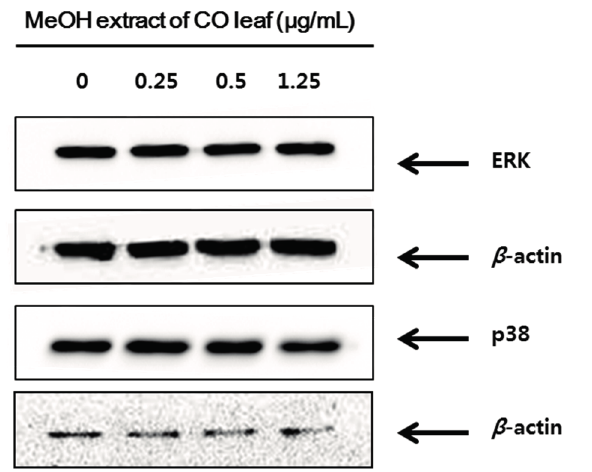
Figure 8. Western blot of HCT116 cells treated with methanol extracts of C. obtusa leaves. Representative western blot of ERK and p38 protein